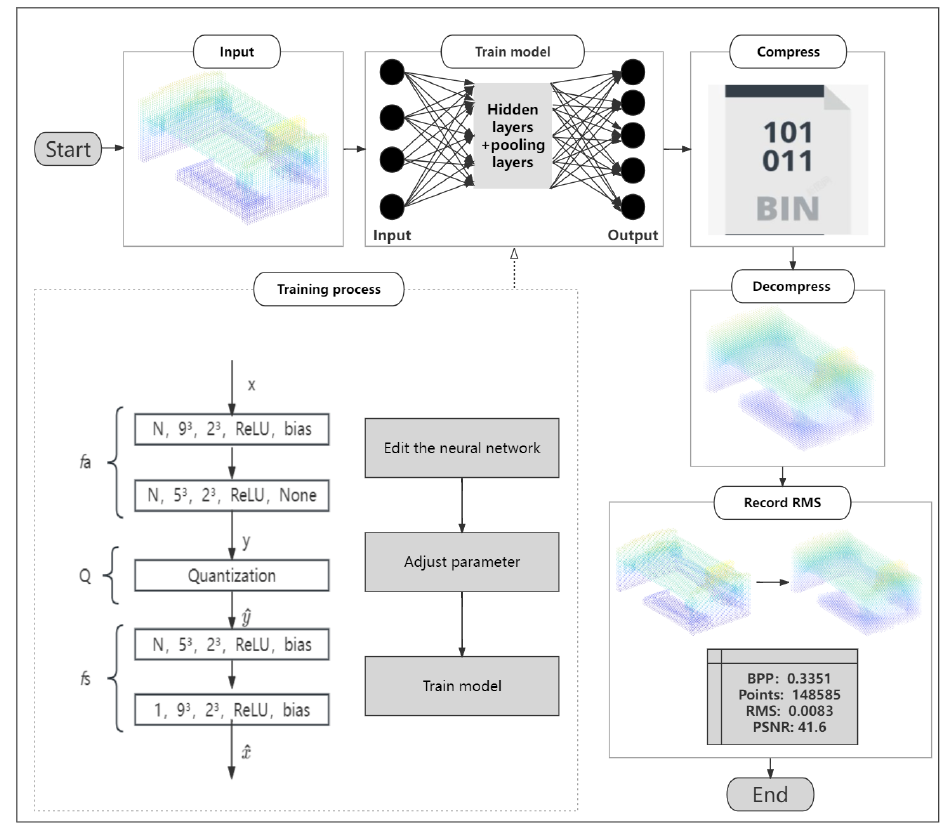
Figure 1. Flow chart of CNN-based 3D point-cloud compression scheme. First, we input the point-cloud model and then use the trained model to obtain the compressed binary file. Then, we decompress the compressed file to compare the decompressed point-cloud model with the one before decompression. Finally, we evaluate the performance by recording the RMS and other parameters between them. The steps of training model are as follows (dash line): First, edit the neural network mesh and adjust convolutional neural network depth, stride, and activation function. Second, adjust the compression accuracy and the number of training rounds. Third, observe model training index total loss and total quantities. If the training requirements are not fulfilled, the model will be retrained until it meets the